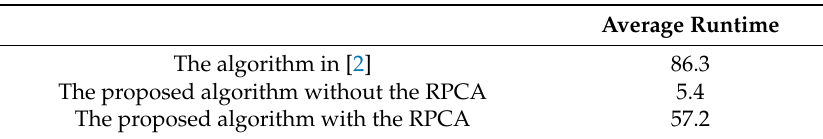
Table 2. The average runtime of the algorithms